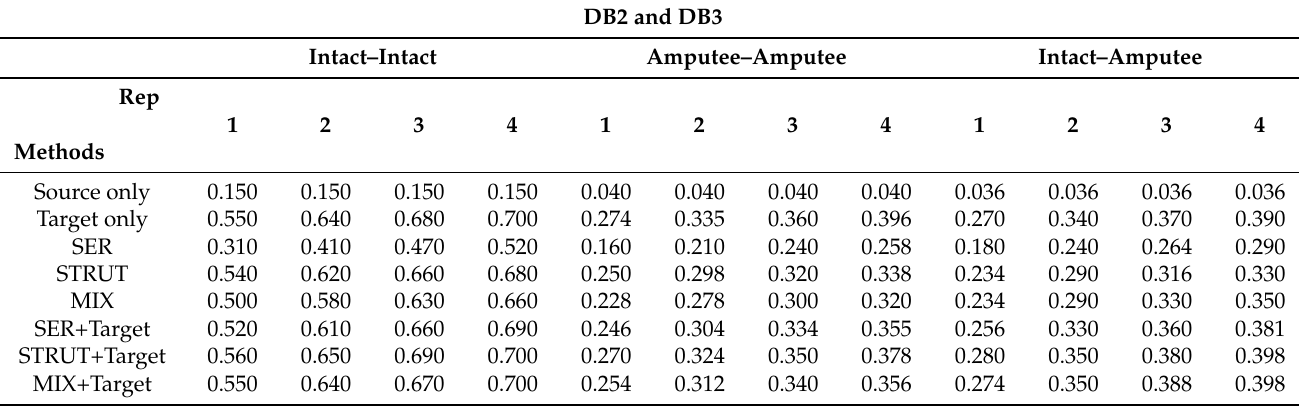
Table 2. Classification methods accuracy on datasets DB2 and DB3 for each combination of subjects and for each repetition.